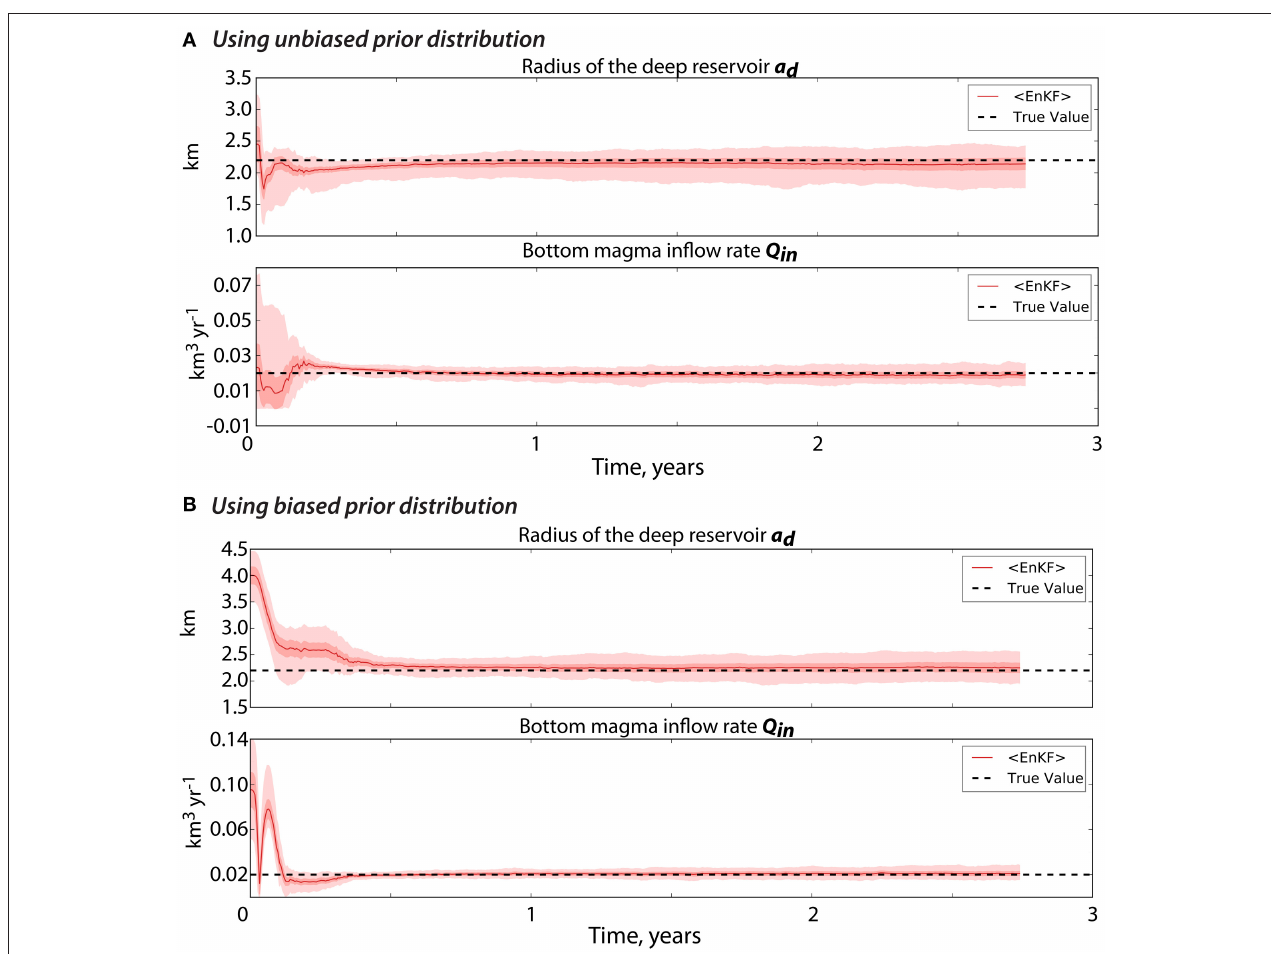
FIGURE 8 | The EnKF-estimated uncertain parameters after performing state-parameter estimation given that the prior distributions of the uncertain parameters are (A) unbiased or (B) biased. The solid red line is the mean value of the uncertain parameters. The dark-shaded red and pink colors represent the spread (1 σ ) and the [min,max] of the ensemble, respectively. The true values are the black broken